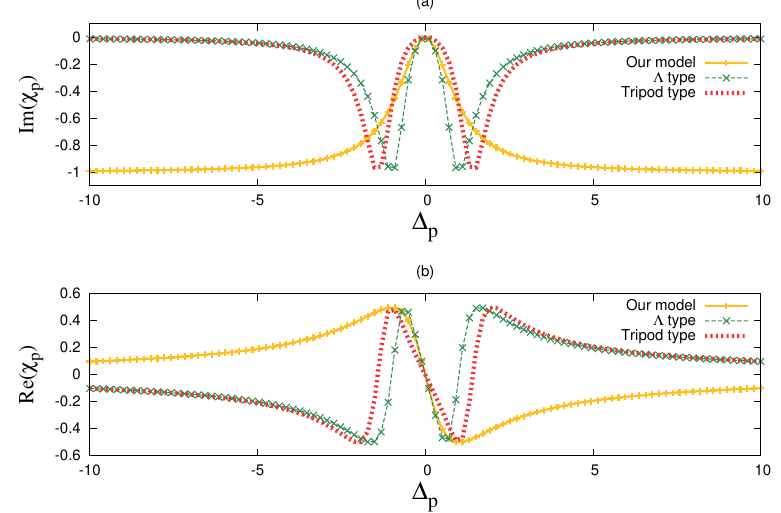
Figure 2. The comparison of our estimation from Equation (20) and two special cases from Equation (21) for linear probe susceptibility χ kl as function of probe field detuning ∆ p . The Λ type configuration corresponds to the n = 2 case in Equation (21), and the tripod type corresponds to the n = 3 case in Equation (21). The parameter settings are ∆ 2 = 0, ∆ 3 = 0, Ω 2 = 1, Ω 3 = 1 in unit of γ kl . The results are separately plotted as: ( a ) The absorption spectra (imaginary part of χ kl ) as function of ∆ p . Here besides the minus sign, there is a offset of unit 1 in y direction in the plot of our model. ( b ) The dispersion spectra (real part of χ kl ) as function of ∆ p